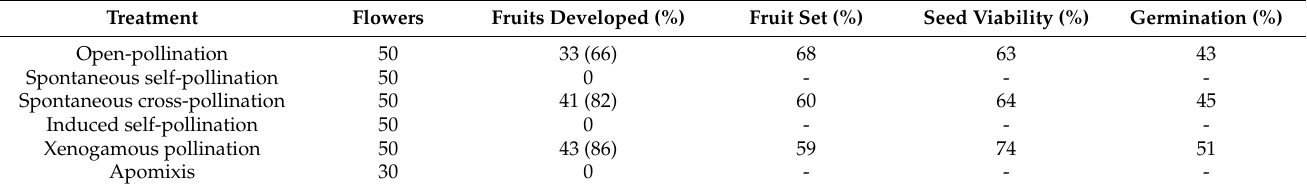
Table 2. Fruit set of Fritillaria michailovskyi under different pollination experiments.